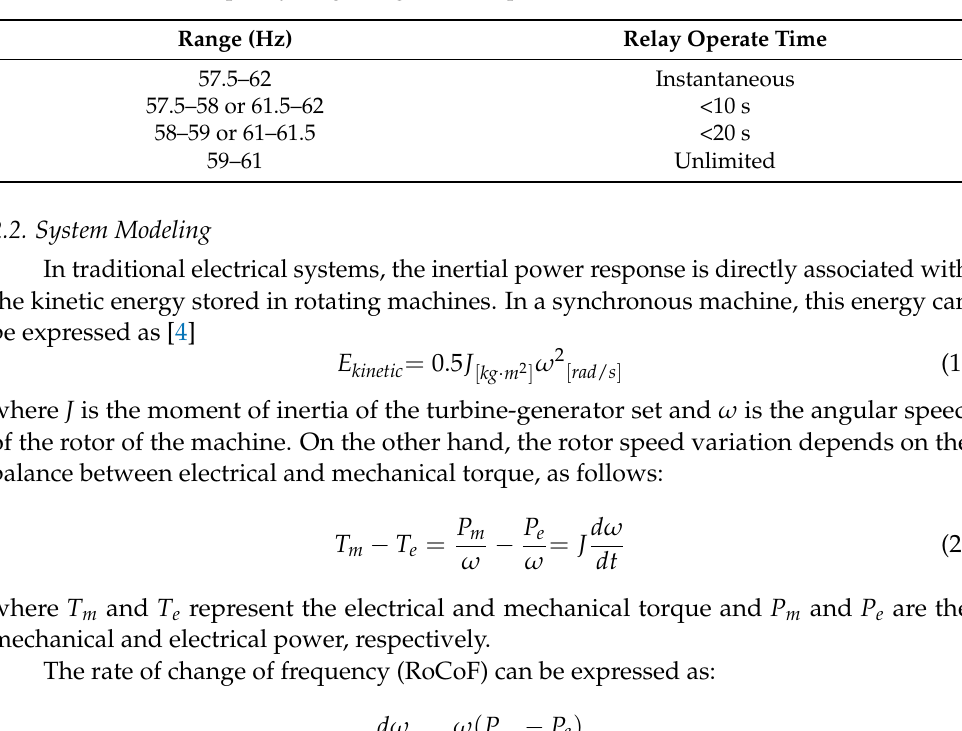
Table 1. Admissible frequency ranges in generator